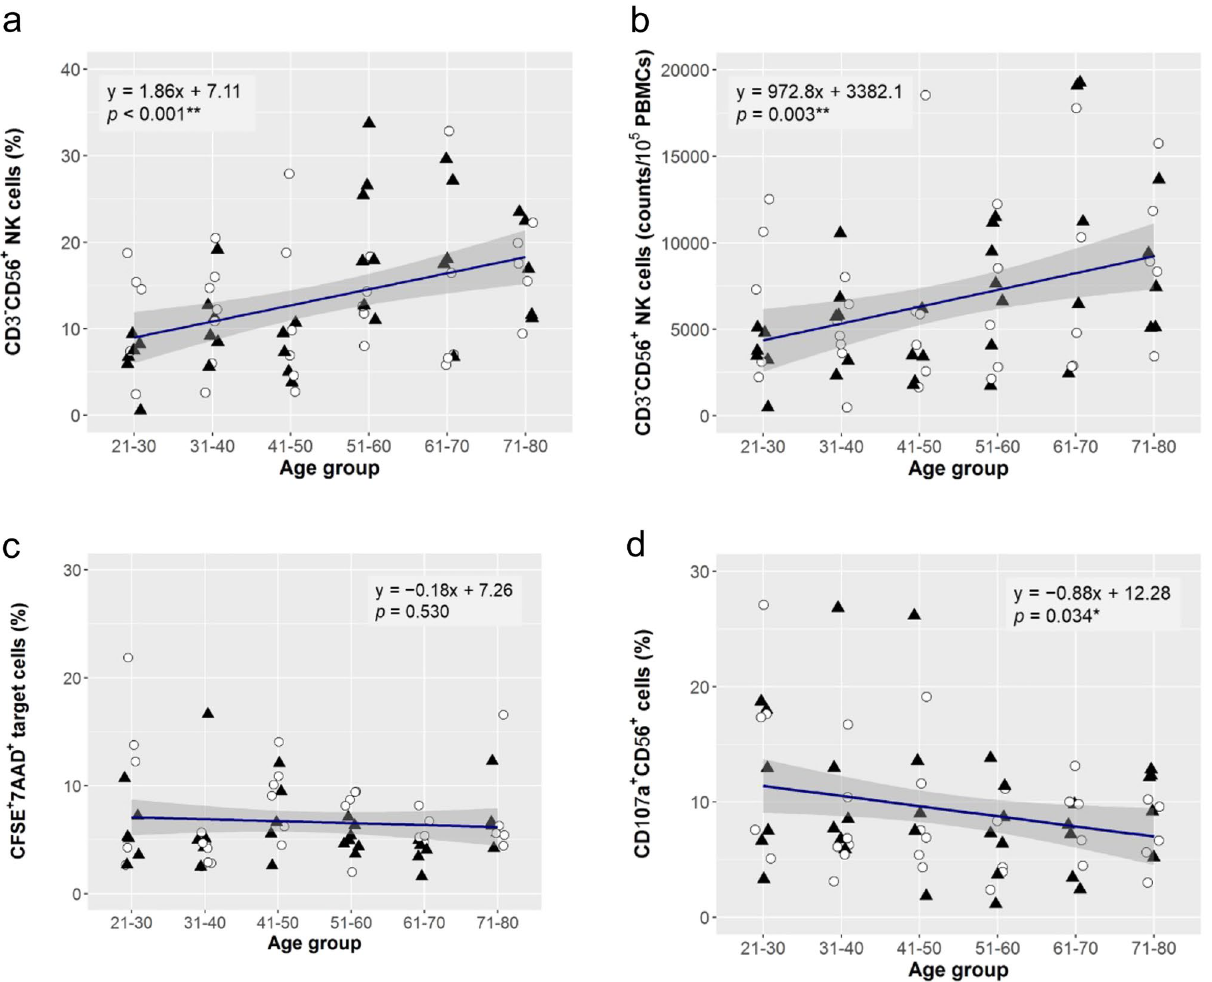
Figure 1. Age-associated changes in NK cells. Linear regression analysis to evaluate the effect of ageing on the percentage of CD3 − CD56 + NK cells gated to total lymphocyte population ( a ), the number of CD3 − CD56 + NK cells in 10 5 PBMCs. ( b ), cytolytic activity of NK cells by direct assay ( c ), and degranulation potential of NK cells by indirect assay ( d ). The linear regression curve is plotted for the data of 67 subjects (33 females: open circle, 34 males: closed triangle), and its equation and p -value (* p < 0.050, ** p < 0.010) for the effect size of ageing are shown. The statistics of the analysis are summarised in Table